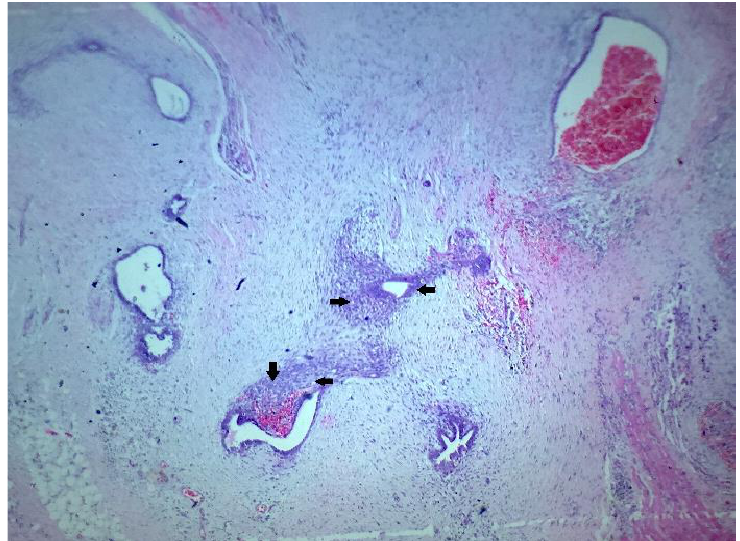
Figure 4. (H&E stain × 40): Scattered numerous endometrial glands along with stroma; a few various calibered, congested, as well as dilated vascular channels; and mixed inflammatory cells predominantly comprising mature lymphocytes, histocytes, and plasma cells embedded against a background of fibro collagenous, muscular, and adipose stroma.